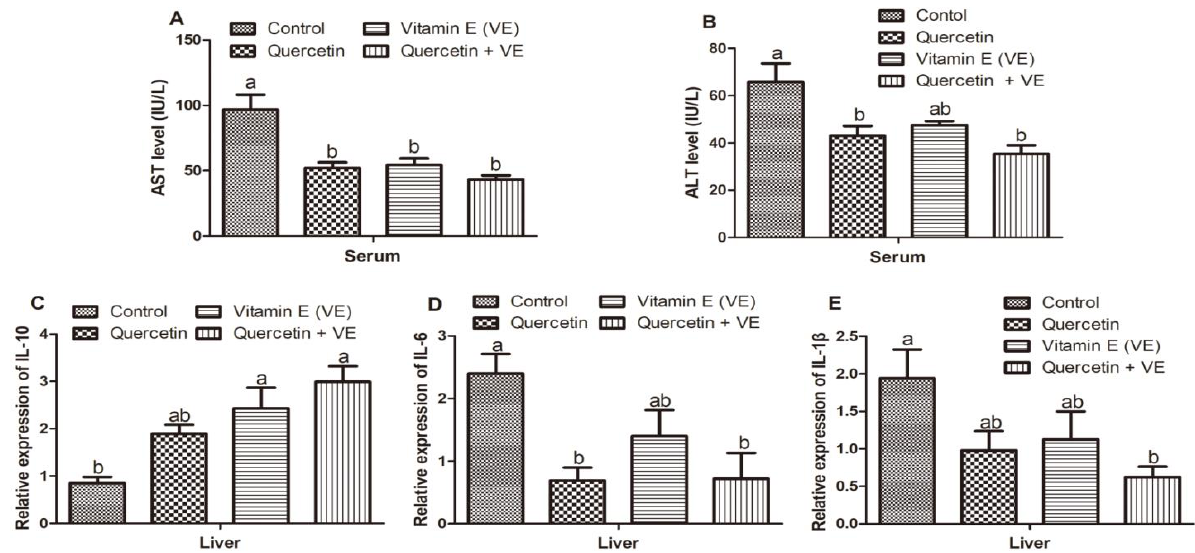
Figure 11. Effects of quercetin, vitamin E, and quercetin + vitamin E on serum AST and ALT levels, and the mRNA expression of inflammation and anti-inflammation related cytokines in the liver of aging breeder hens. Levels of AST ( A ), ALT ( B ), IL-10 ( C ), IL-6 ( D ), and IL- 1β ( E ). The values are presented as the mean ± SD. Bars without the same letter differed significantly ( p < 0.05).